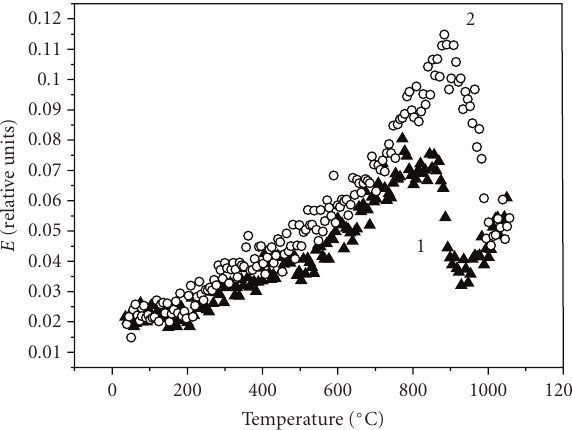
Figure 3: DSA results of sample A (curve 1) and sample B (curve 2) measured during heating in air at the rate of 6